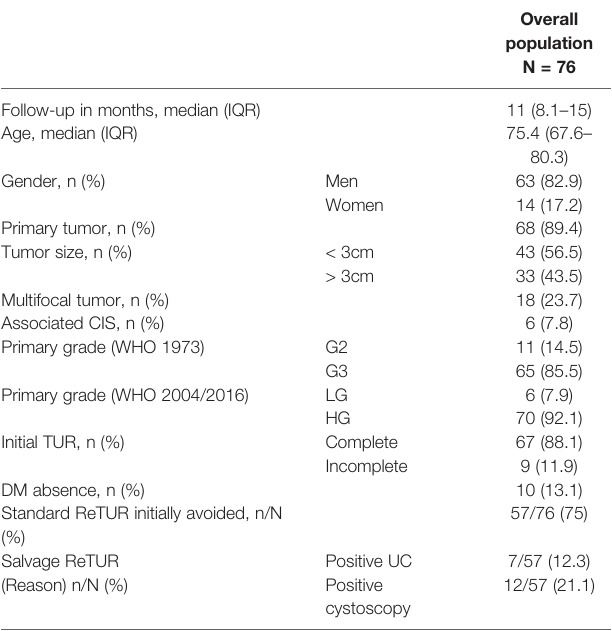
TABLE 1 | Characteristics of the patients.